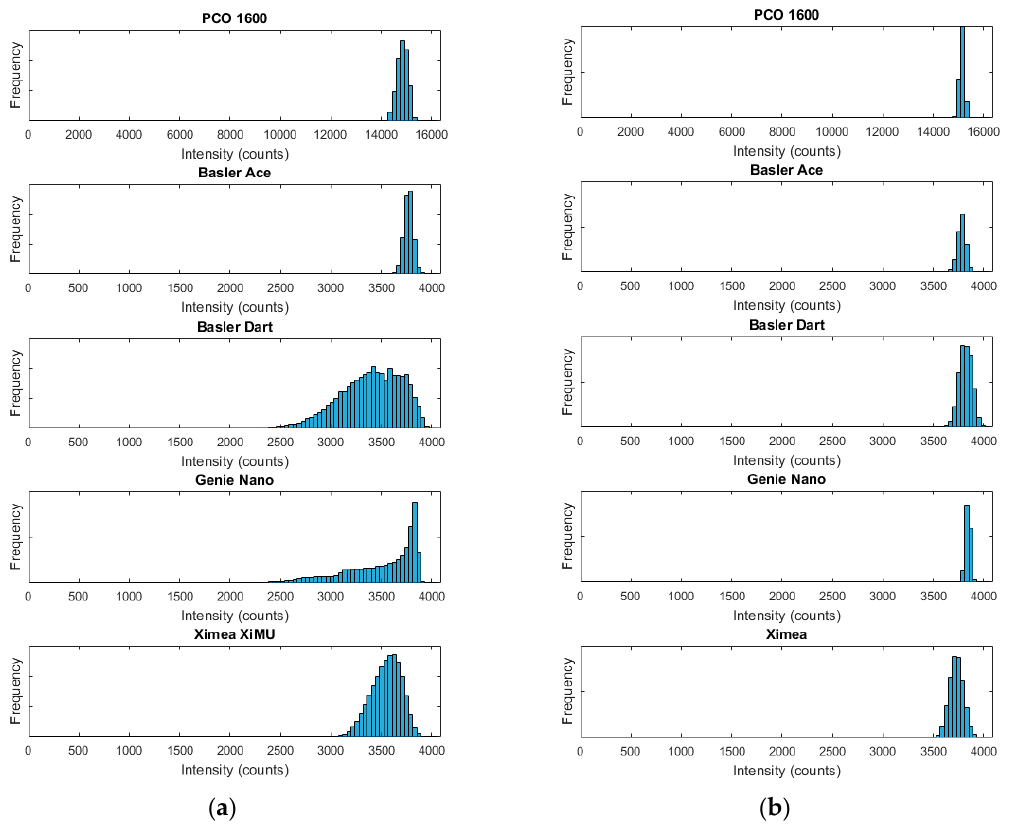
Figure 3. ( a ) Histogram output of complete image and ( b ) histogram output of 300 × 300 pixel region of interest in centre.